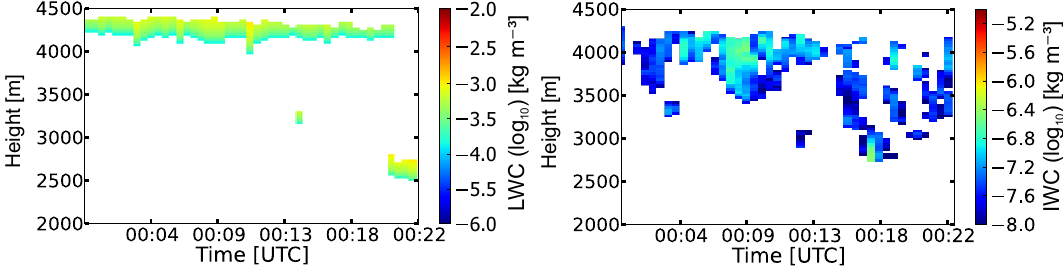
Figure 2. Cloudnet derived water contents for case 1. Left: liquid water content; right: ice water content (both in logarithmic scale).